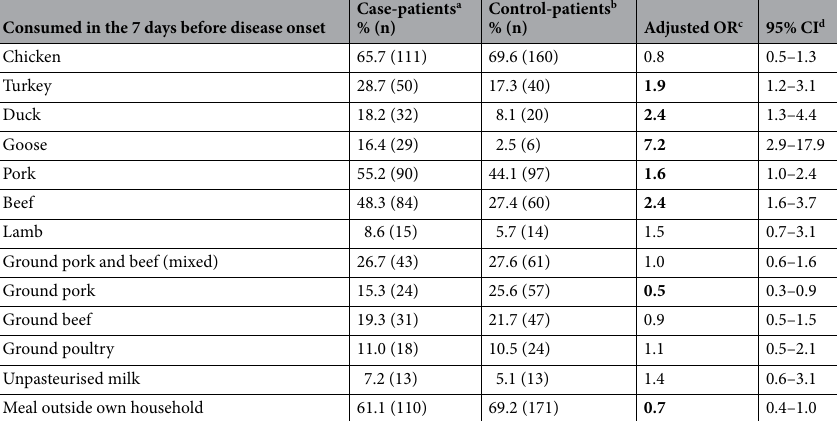
Table 4. Single variable logistic regression analysis (adjusted for sex and age group) of case-patients (n = 182) and control-patients (n = 260) regarding exposure to certain food items in the 7 days before disease onset; case-control study, Germany, 2018/2019. a Case-patients: Disease onset 25 December 2018–8 January 2019. b Control-patients: Disease onset 30 November–24 December 2018, or 9 January–28 February 2019. c Odds ratio (adjusted for age group and sex). Statistically significant odds ratios ( P -values ≤ 0.05) are depicted in bold. d Confidence